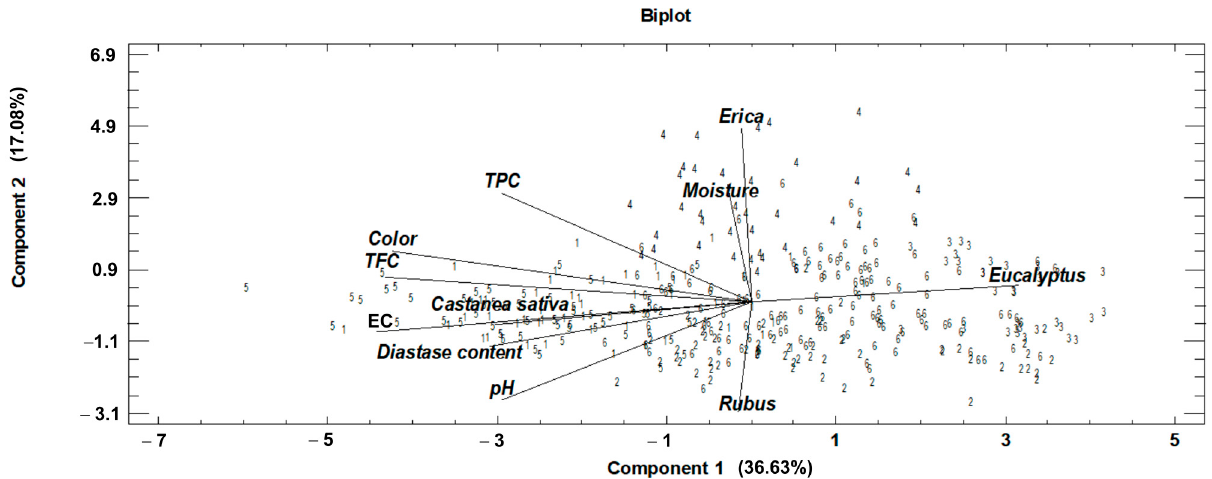
Figure 1. Biplot of the first two components and distribution of honey samples extracted by